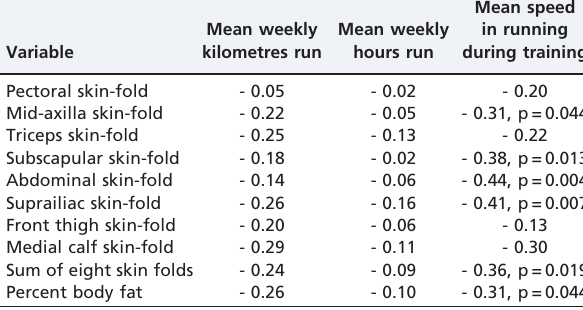
Table 5 - Association between skin-fold thicknesses and training